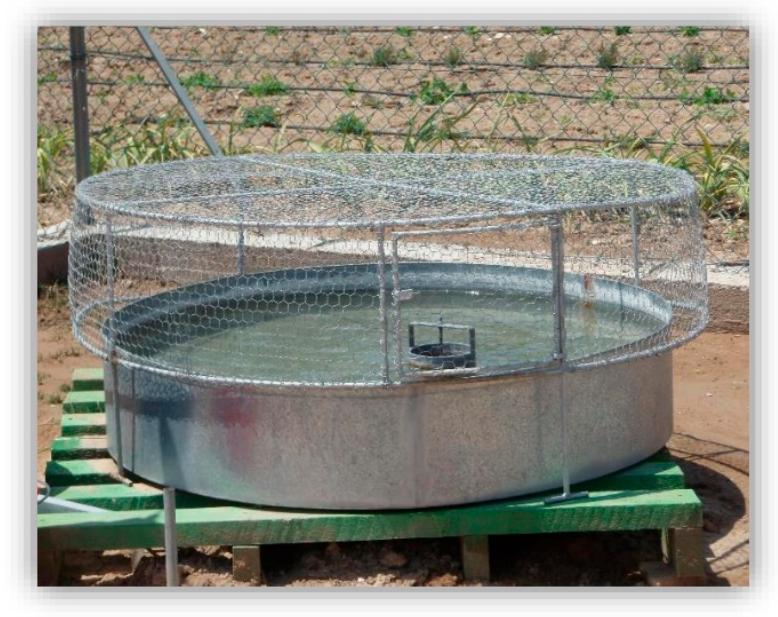
Figure 2. Class A evaporation pan.